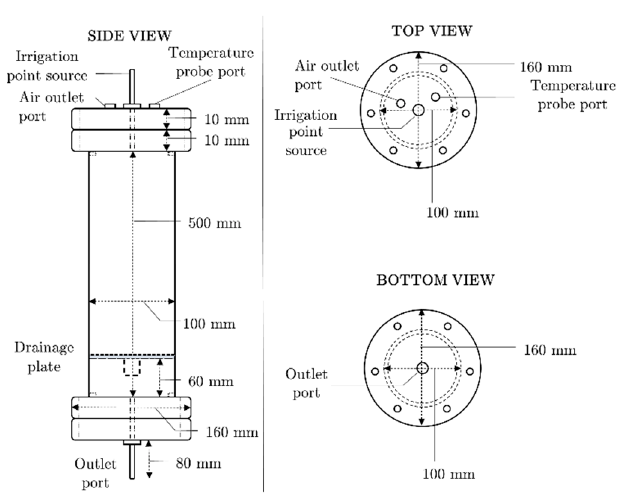
Figure 4. Cylindrical column design and dimensions used in tracer tests [29].